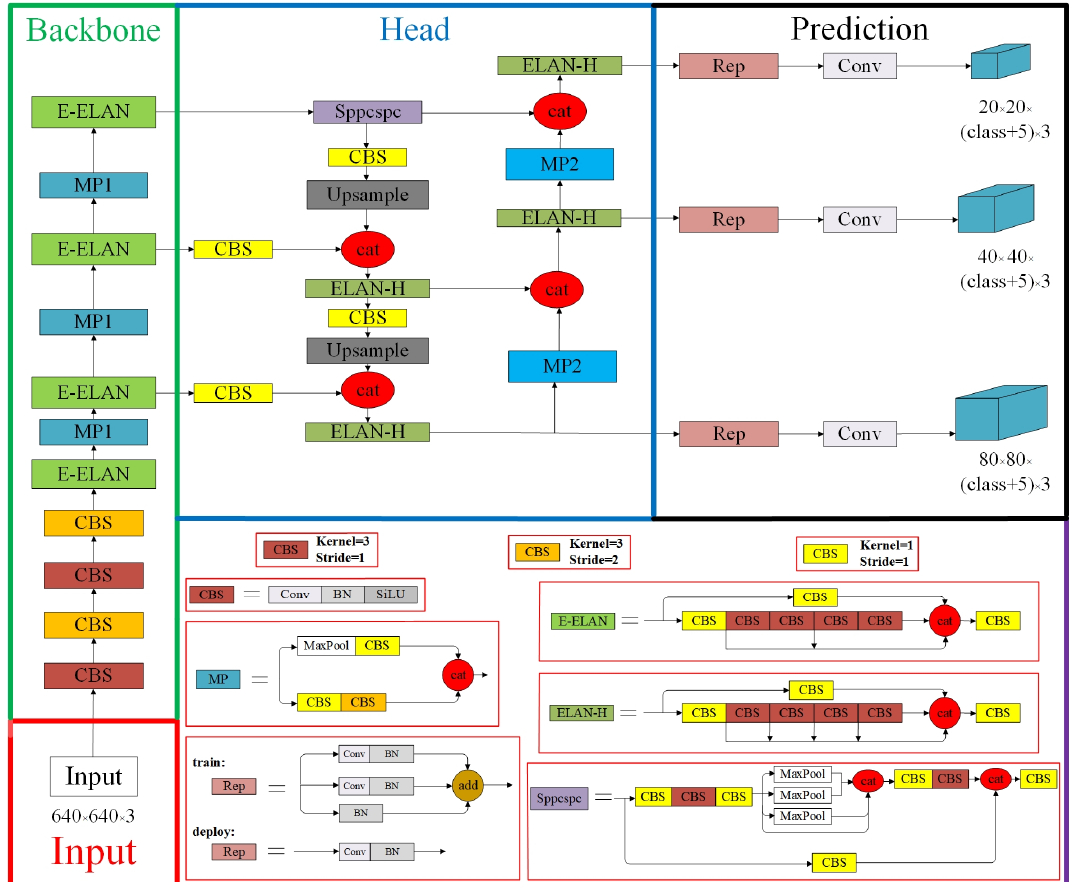
Figure 1. The network structure of YOLOv7 .